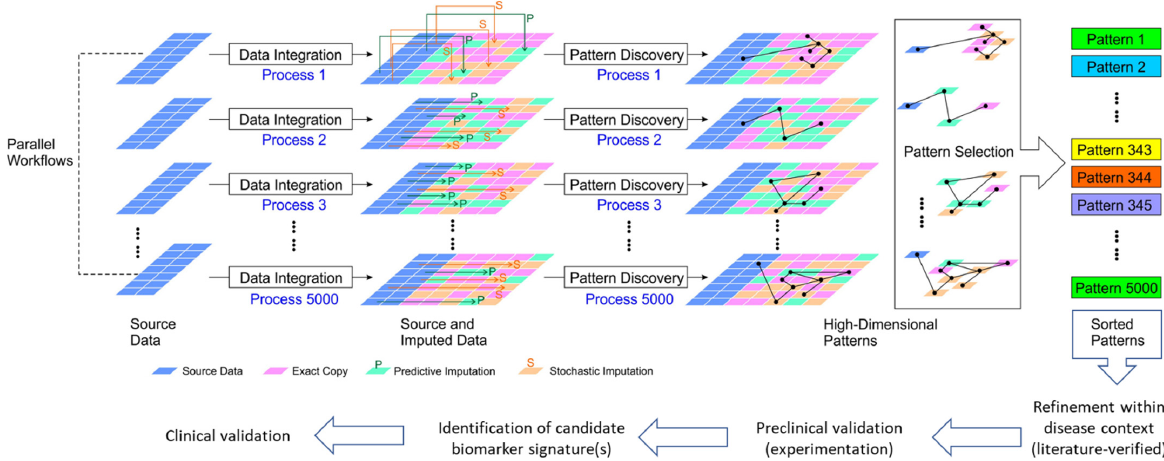
Figure 1. Schematic illustration of our proposed very-large-scale predictive data integration and imputation process for high-dimensional pattern discovery as candidate biomarker signatures. The source parallel multi-omics data are amplified in multiple data imputation processes (see Methods). Predictive imputation uses the dependencies between data dimensions to fill in missing data and replace data with uncertainty in different configurations. Stochastic imputation further increases the variety of generated data by helping existing data to form more variety of patterns. Using this framework, we can expose more data patterns to the accessible operational range of existing pattern recognition algorithms. Data imputation tools provide more frequent and more diversified opportunities for pattern discovery [19]. Thus, the hidden patterns are placed at shallower, easier to discover data entry locations for many imputation instances. This very-large-scale data